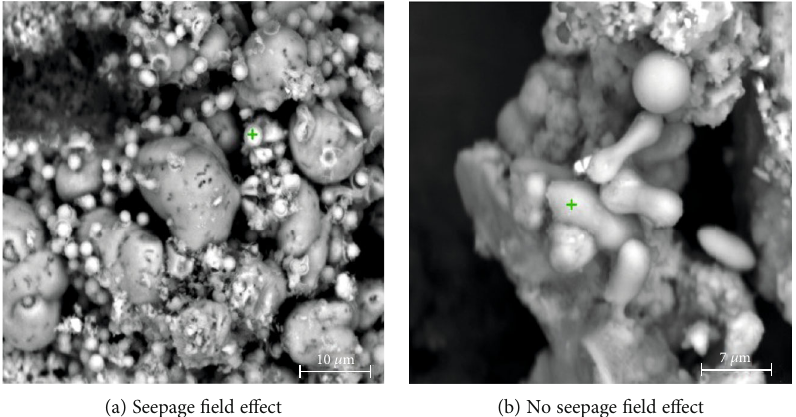
Figure 5: Particle bonding images with and without the e ff ect of the seepage fi